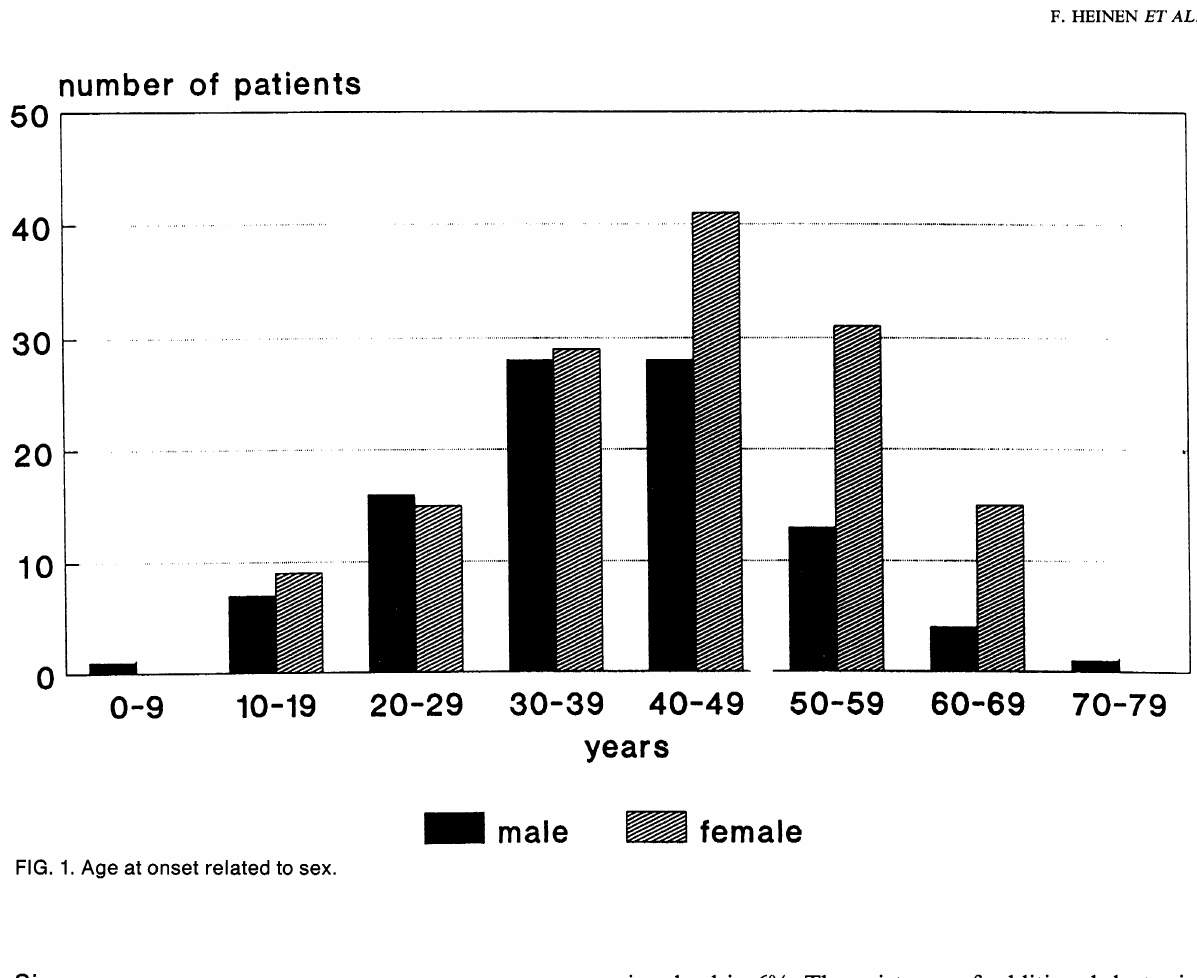
FIG. 1. Age at onset related to